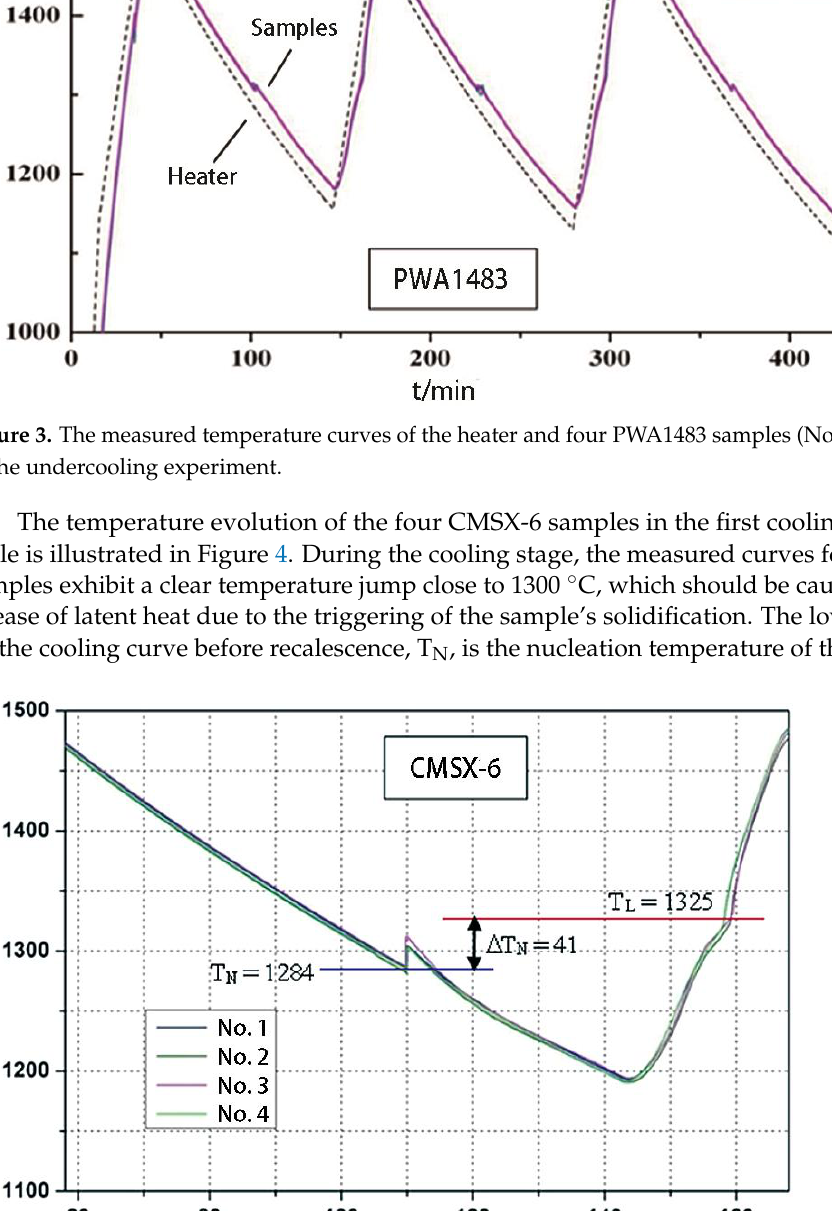
Figure 4. Temperature curves of the four samples of alloy CMSX-6 (No. 1 to No. 4 ), recorded in the